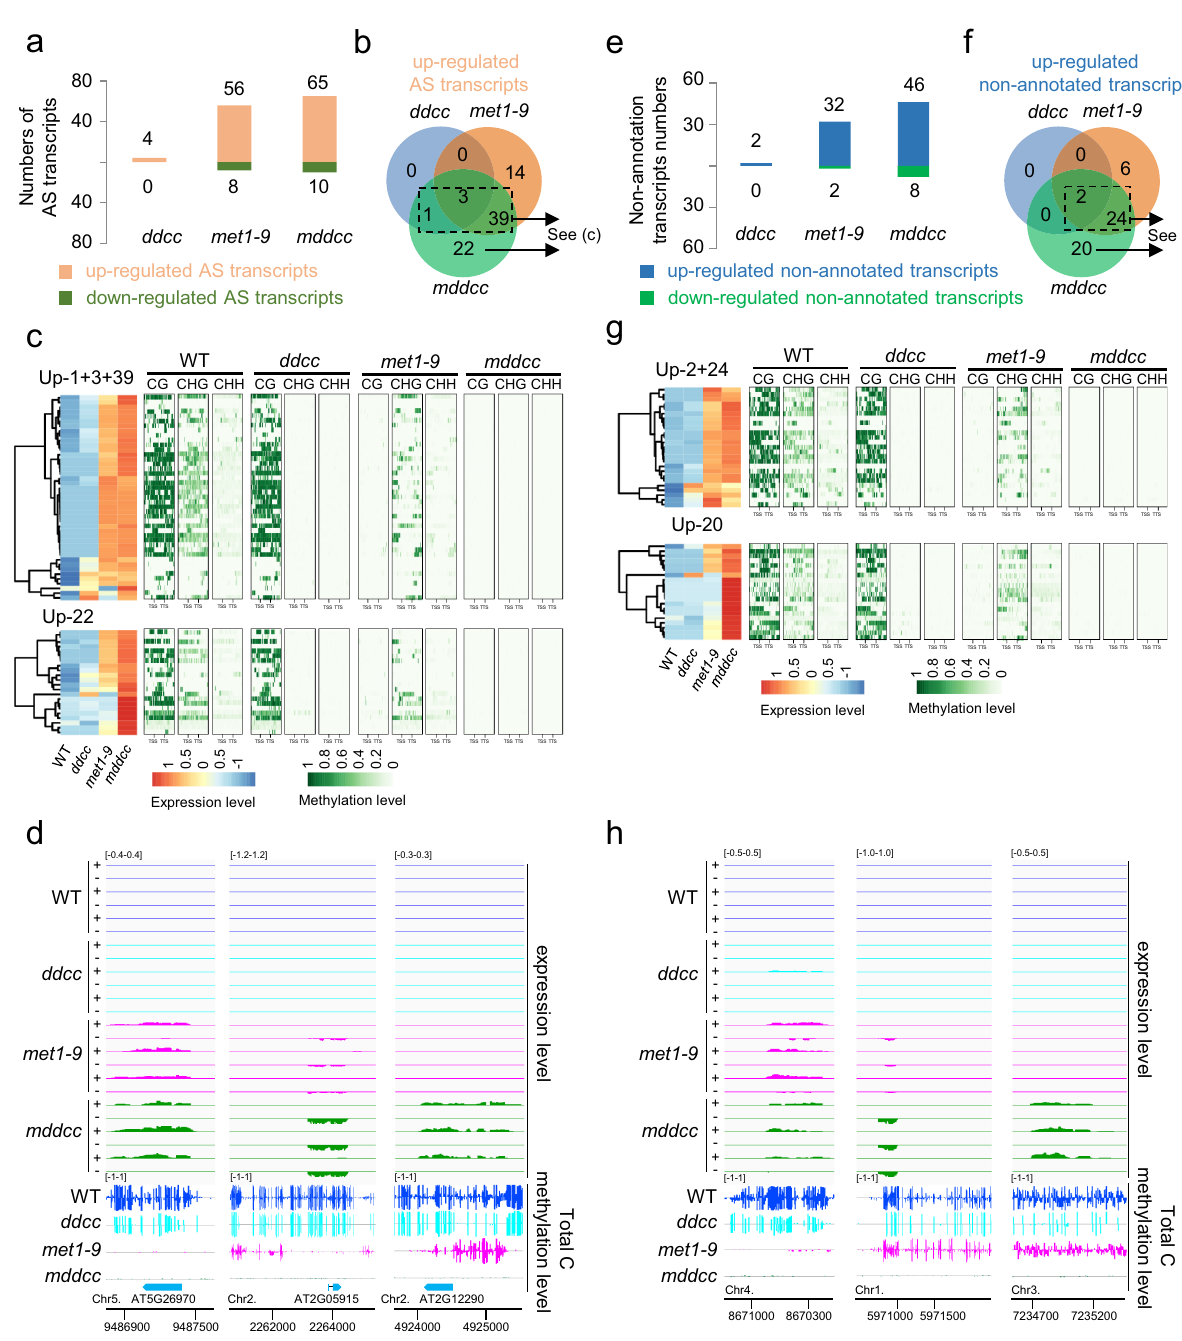
Fig. 4 DNA methylation represses the expression of antisense and non-annotated transcripts. a Numbers of differentially expressed antisense (AS) transcripts in the indicated mutants relative to WT. b Venn diagram showing the overlap among up-regulated AS transcripts in ddcc , met1-9 , and mddcc mutants. c Heat maps showing the expression and DNA methylation patterns of the antisense transcripts in the indicated groups. d Snapshots of expression and DNA methylation levels over three antisense transcript genes in the indicated mutants. e Number of differentially expressed non-annotated transcripts in the indicated mutants relative to WT. f Venn diagram showing the overlap among up-regulated non-annotated transcripts in ddcc , met1-9 , and mddcc mutants. g Heat maps showing the expression and DNA methylation patterns of the non-annotated transcripts in the indicated groups. h Snapshots of expression and DNA methylation levels over three non-annotated transcripts in the indicated